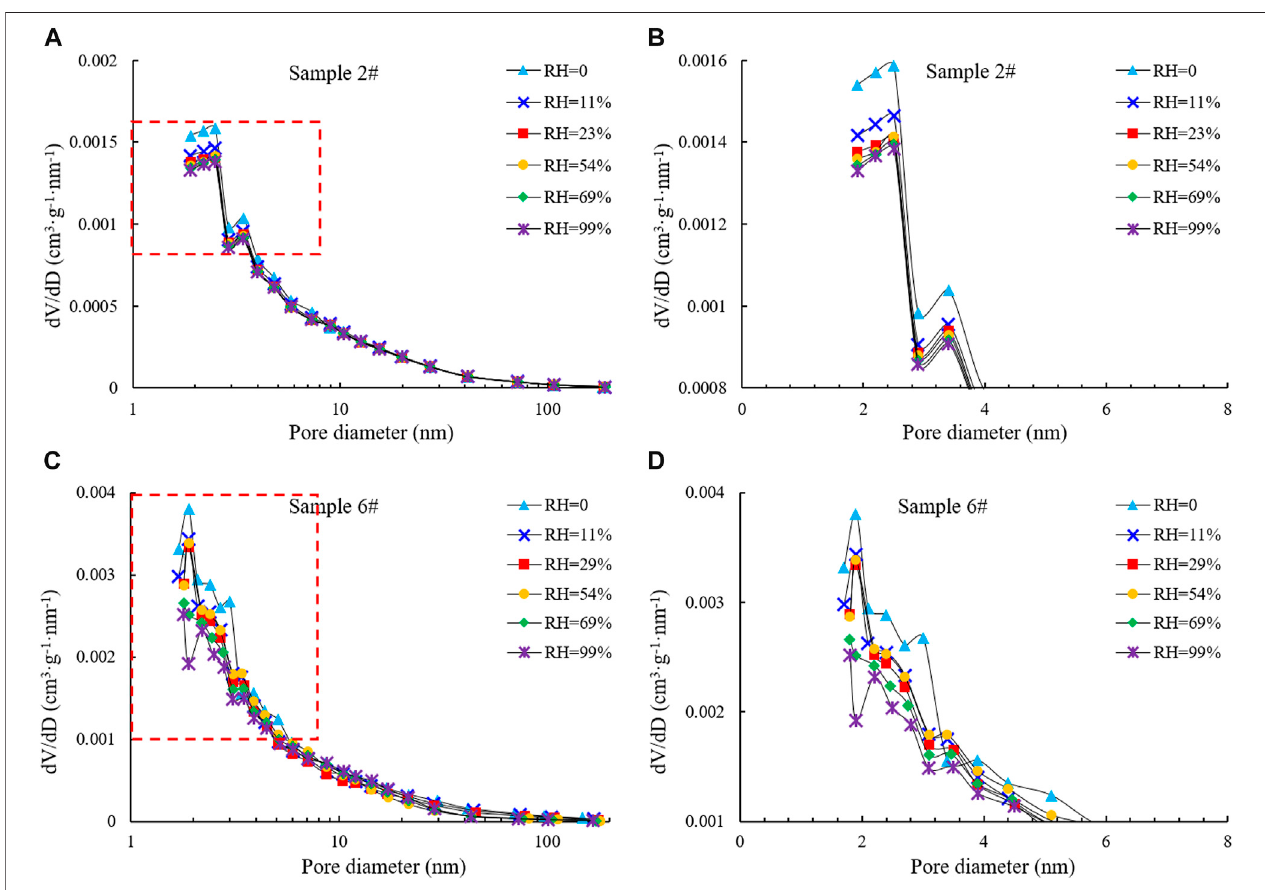
FIGURE 9 | Pore size distribution characteristics of samples #2 and #6 with different humidity.